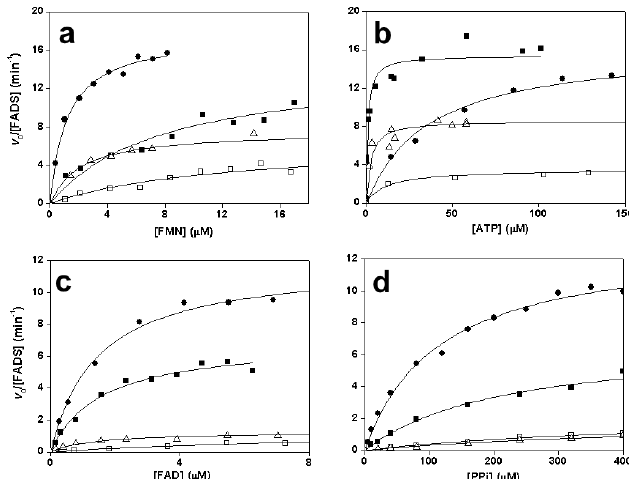
Figure 2. Steady-state rates for the FMNAT activity at saturating ( a ) ATP and ( b ) flavin mononucleotide (FMN)) concentrations, and for the FADpp activity at saturating ( c ) PPi and ( d ) flavin adenine dinucleotide (FAD) concentrations of WT (●), R161A (■), R161D (□) and T165A (∆) Ca FADS